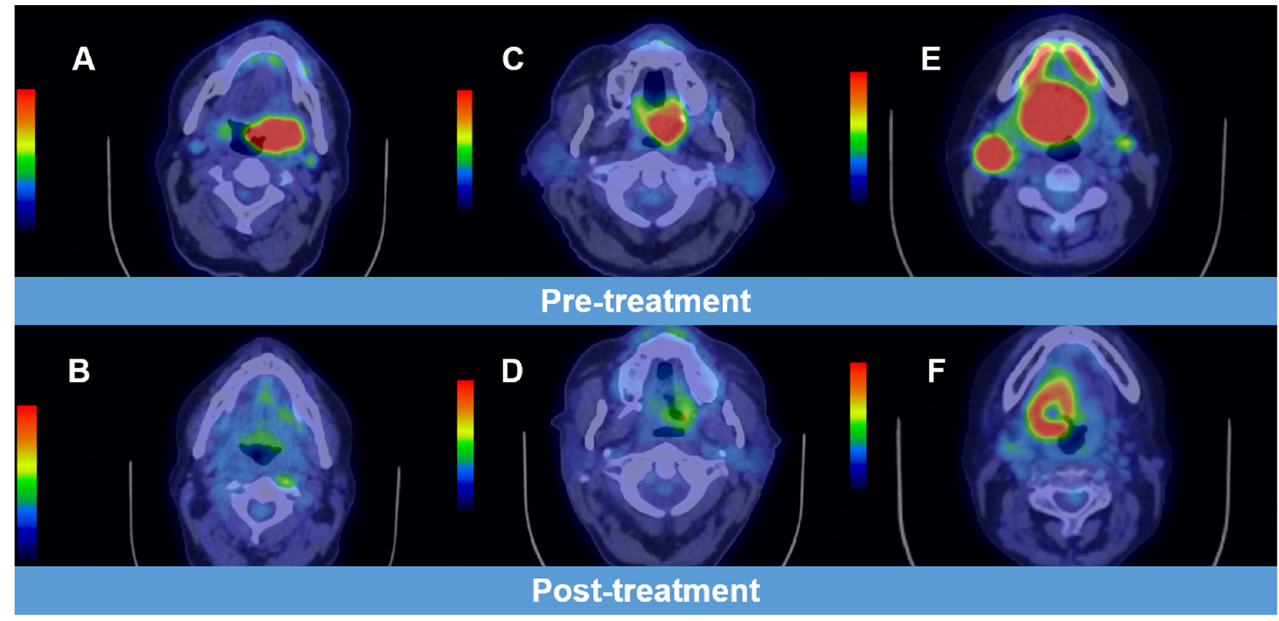
Figure 2. Examples of imaging illustrating positive, equivocal, and negative results on response assessment PET-CT. ( A ) Baseline PET-CT for a patient with T4N1M0 p16-ve squamous cell carcinoma of the tonsil (SUVmax 23.5, with ( B ) showing a negative response assessment PET-CT (absent abnormal focal FDG uptake). ( C ) Baseline PET-CT for a patient with T4N2bM0 p16-ve squamous cell carcinoma of the soft palate (SUVmax 15.3), with ( D ) showing an equivocal response on assessment PET-CT (SUVmax 4.2). ( E ) Baseline PET-CT for a patient with SCC T4N2cM0 p16-ve squamous cell carcinoma of the base of the tongue (SUVmax 13.4), with ( F ) showing a positive response on assessment PET-CT (SUVmax 10.5).